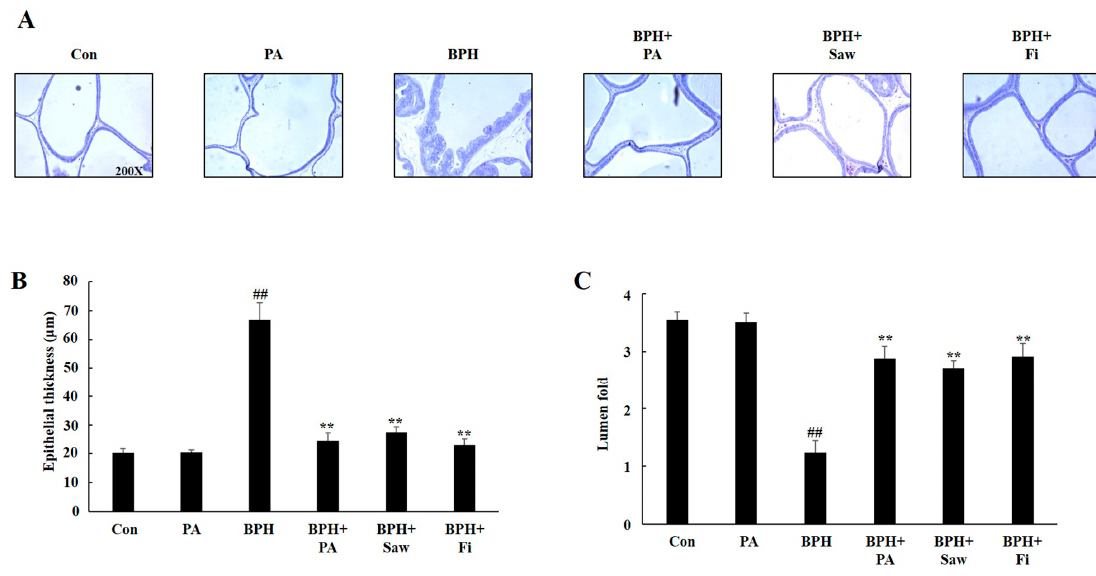
Figure 4. Effects of PA administration on prostate histology in rats with TP-induced BPH. ( A ) Representative photomicrographs of hematoxylin and eosin (H&E)-stained prostate tissues (magnification 100×). ( B ) Epithelial thickness of the prostate tissues. ( C ) Relative lumen area of the prostate tissues. Abbreviations: Con, corn oil, s.c., and D.W.-treated rats; PA, corn oil, s.c., and PA 100 mg/kg-treated rats; BPH, TP, s.c., and D.W.-treated castrated rats; BPH+PA, TP, s.c., and PA 100